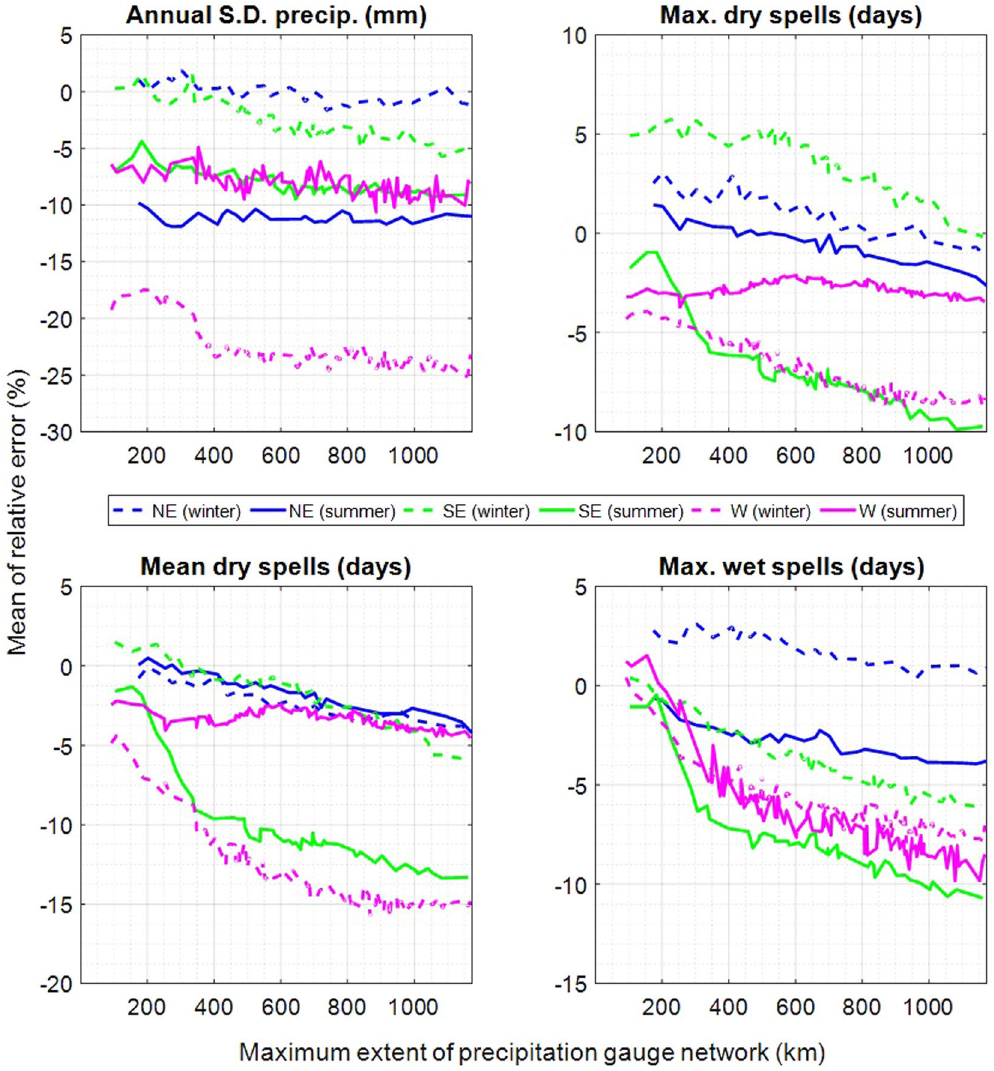
Figure 3. Relative error for all sites in the North-East (blue), the South-East (green) and the West (magenta) for the summer (solid lines) and winter season (dashed lines). The error is plotted for four metrics against the maximum extent of each simulated gauge network. For each study area, the lines show the mean of the four simulations (using four different starting sites; see Fig.